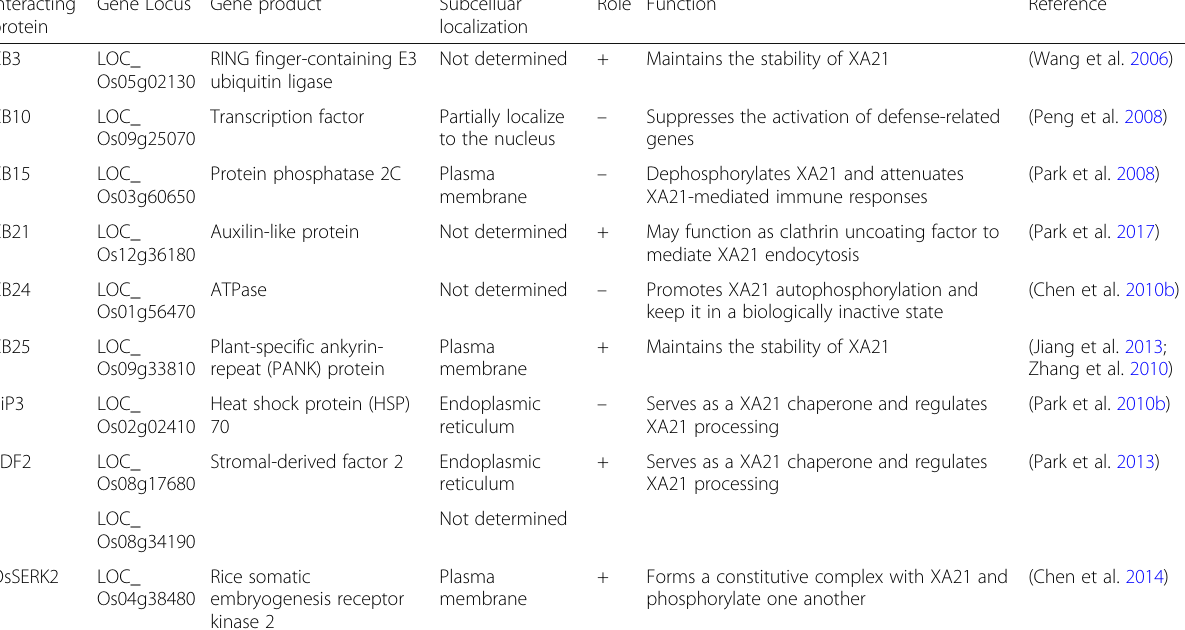
Table 2 Summary of XA21-binding proteins Interacting protein